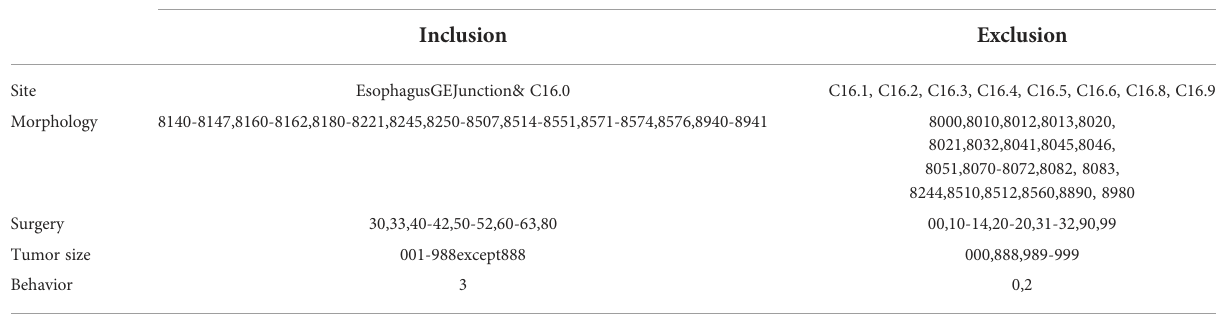
TABLE 1 Inclusion and exclusion codes for the US